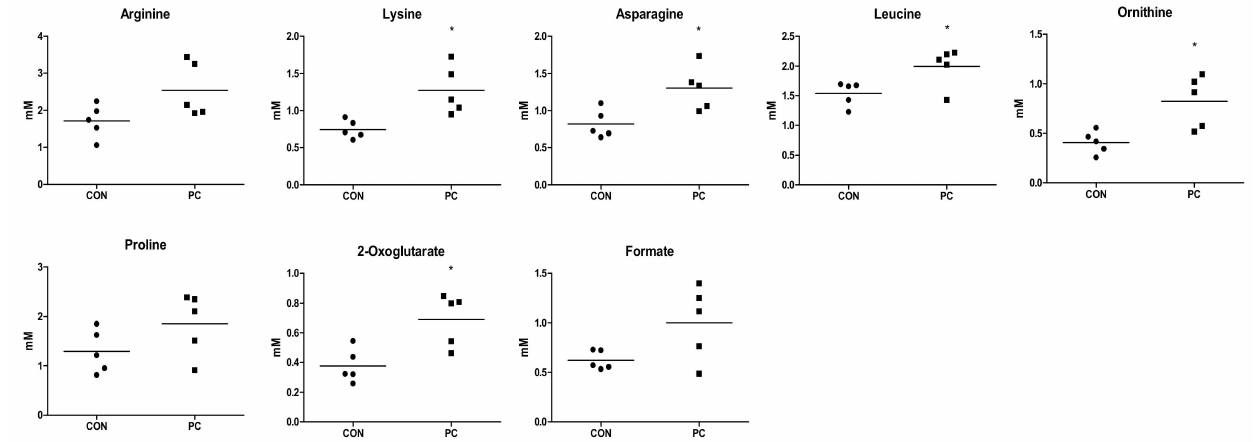
Figure 5. Concentrations of endogenous metabolites in serum samples of mice. Major serum metabolites (variable importance plot (VIP) ≥ 0.5), t -test and Unpaired t -test were performed to assess statistical significance compared with control (CON) and positive control (PC); • , CON; (cid:4) , PC; *, p < 0.05.